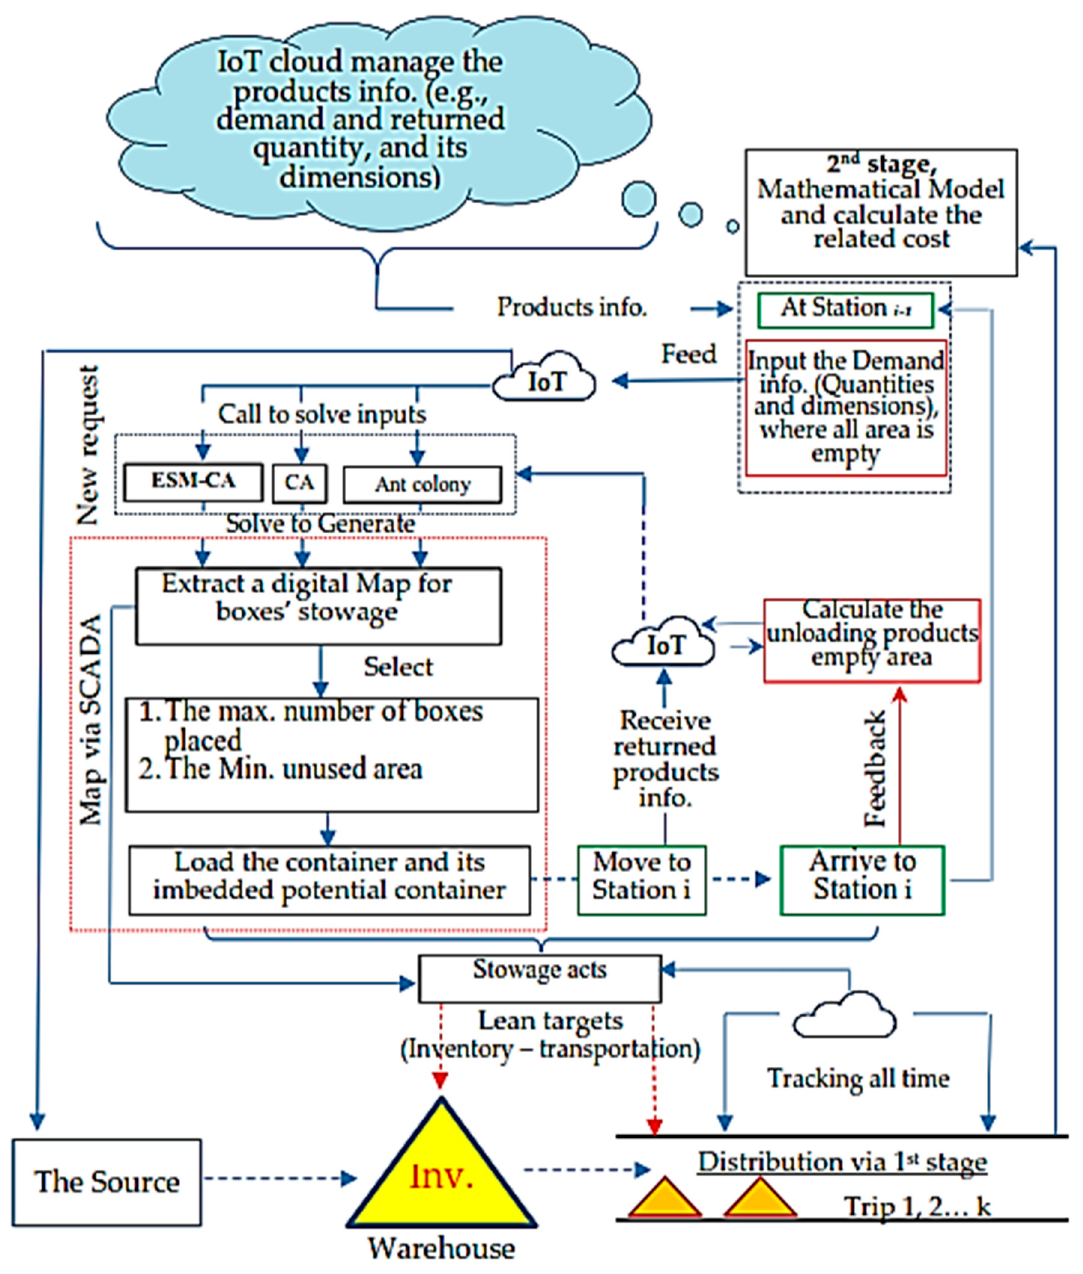
Figure 2. The e-commerce framework.